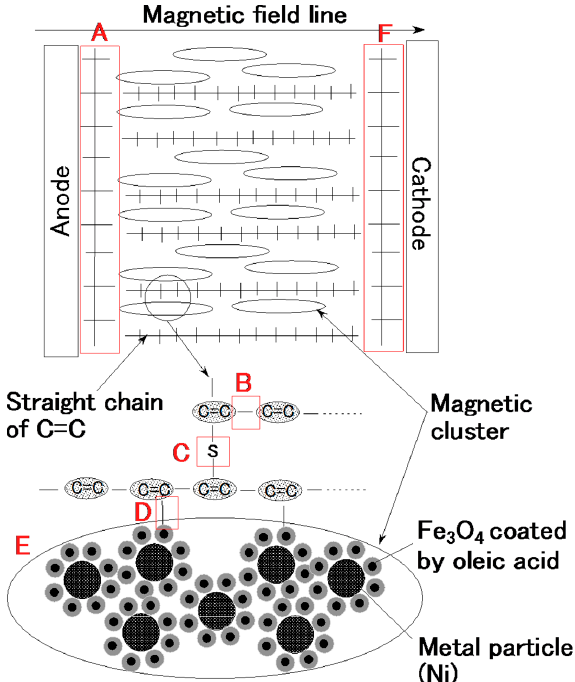
Figure 4. Model of electrolytic polymerization and solidification of the MCF rubber by the present new method.